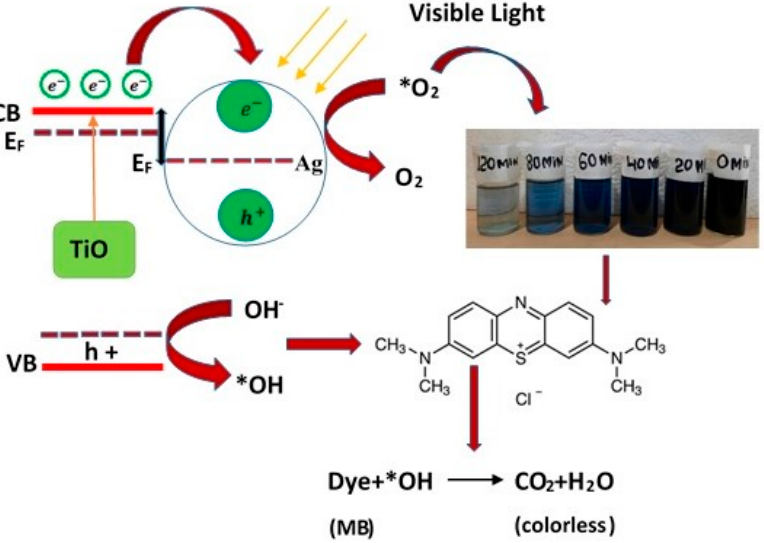
Figure 8. Schematic of mechanism of photoactivation of Ag/TiO 2 catalyst for degradation of synthetic dyes.